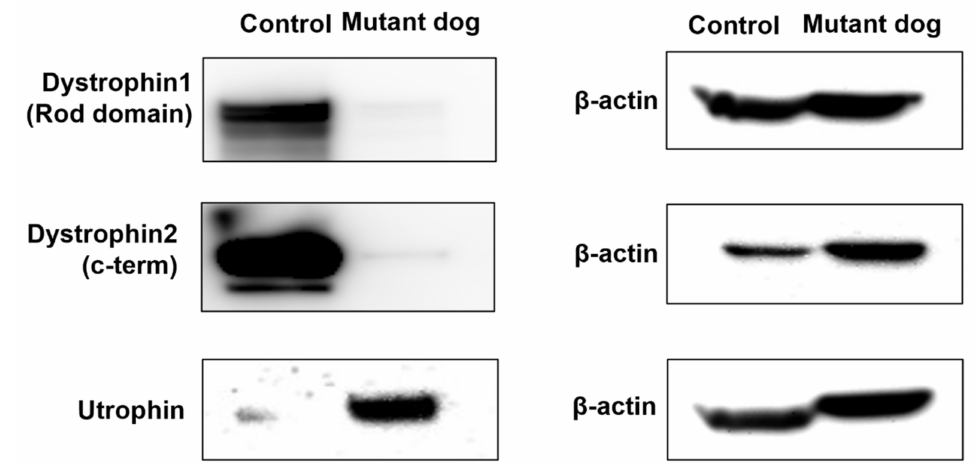
Figure 4. Western blot confirming the negligible expression of dystrophin 1 and 2 and upregulation of utrophin in dystrophin mutant dog (Mutant dog) and control